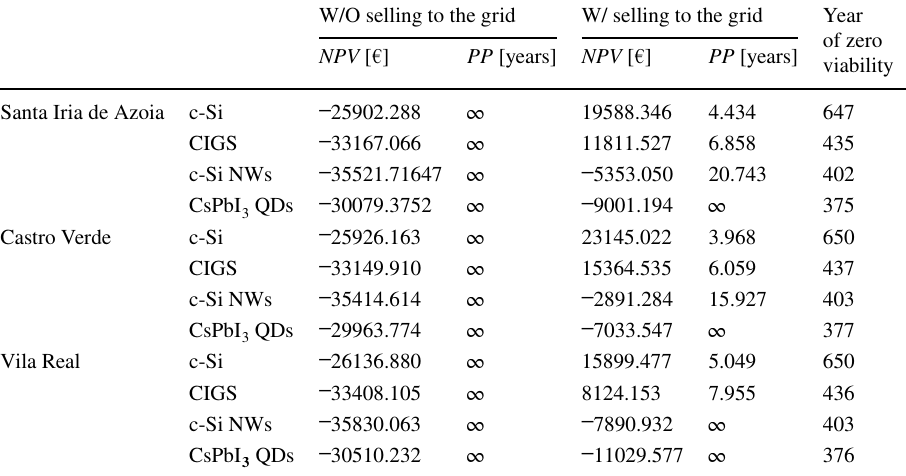
Table 12 Summary of financial indicators for each technology, per